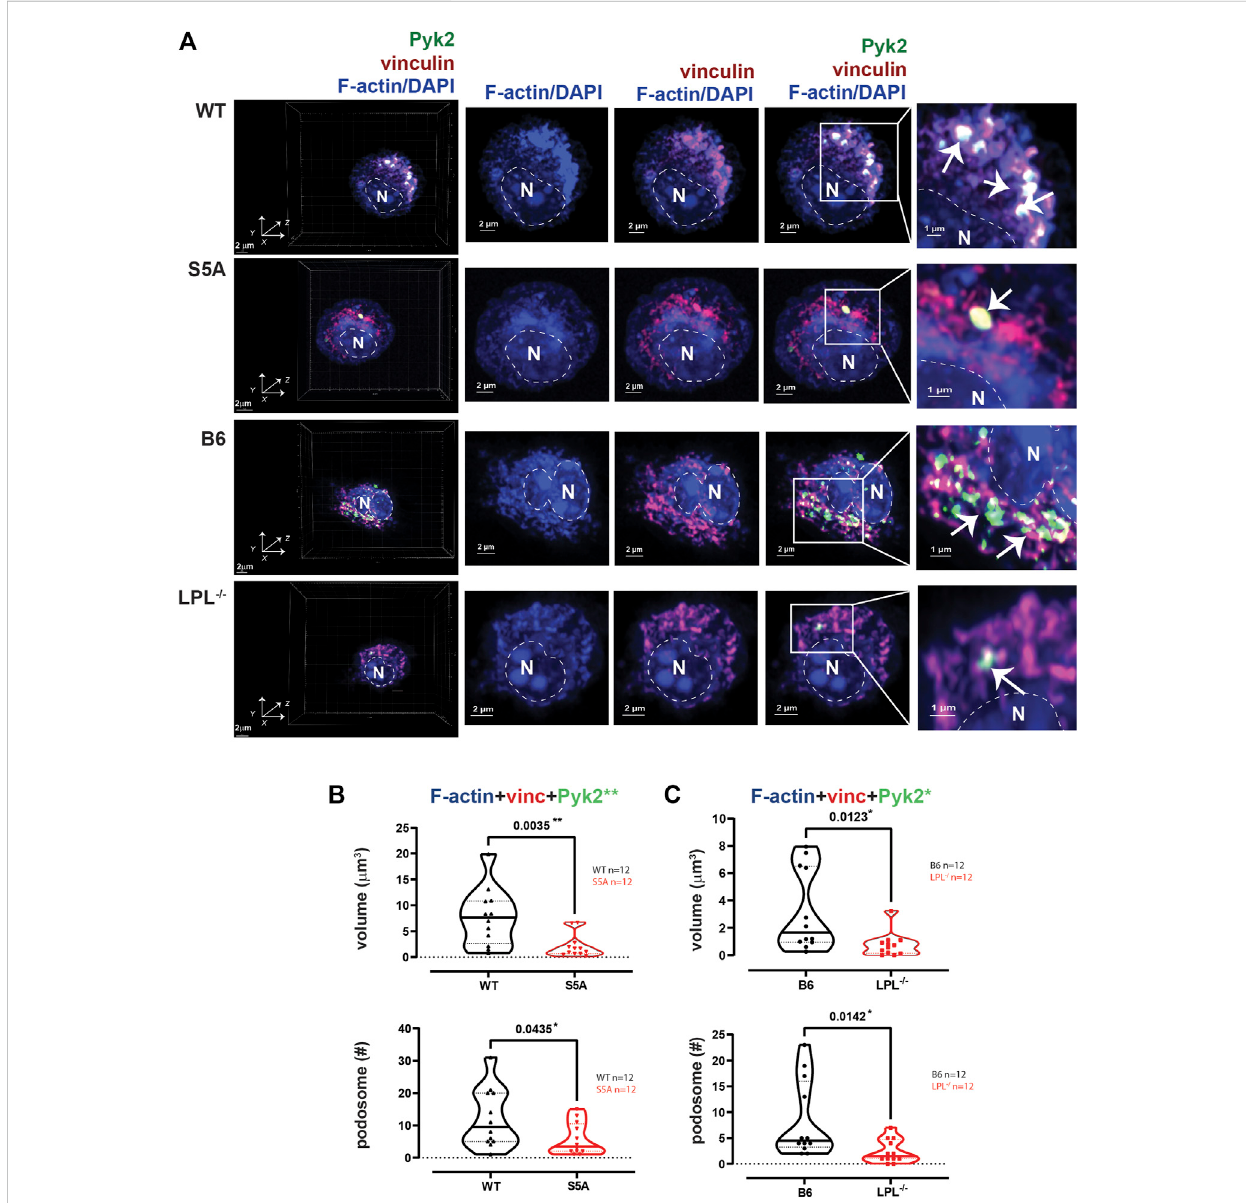
FIGURE 6 Podosome formation during incubation on coverslips, without additional stimulation, requires S5-phosphorylation of LPL. (A) Co-localization of Pyk2 (green), vinculin (red) and F-actin (blue) in AMs derived from matched WT and S5A or B6 and LPL − / − mice after 60 min incubation on coverslips without additionalstimulation.60minwasselectedasthedurationtocorrespondthe60 minpost-isolation durationofincubationofAMsanalyzedafter serum stimulation and withSpn infection. Far leftpanels show 3DreconstructionofZ-stackconfocal micrographs.Overlays ofvinculin with F-actin andofPyk2withvinculin+F-actinareshowntoindicatehow “ volumes ” arederivedinsubsequentanalyses.Podosomesareaggregatesinwhichallthree proteins are co-localized (arrows), magni fi ed in insets. DAPI was used to image nucleus. ( “ N ” and dotted line). Grids show 2 μ m increments and are optimal for size assessment; scale bars in subsequent panels are derived from grids. (B) Volumes of aggregates of co-localized F-actin + vinculin + Pyk2, and the number of aggregates ≥ 0.07 μ m 3 in AMs from matched WT and S5A mice. (C) Volumes of aggregates of co-localized F-actin + vinculin + Pyk2, and the number of aggregates ≥ 0.07 μ m 3 in AMs from matched B6 and LPL − / − mice. (B, C) Each symbol represents the volume calculated from one AM; n = number of cells analyzed. Images acquired from two independent experiments. p -values determined by Mann-Whitney; * p < 0.05, ** p <